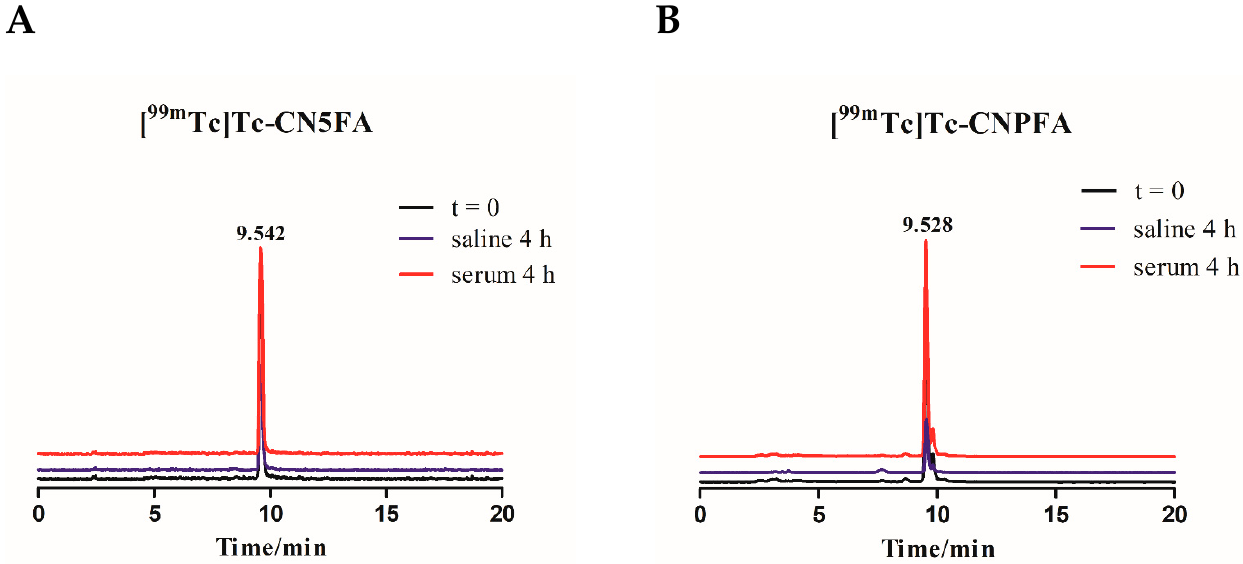
Figure 1. Radiochromatograms of [ 99m Tc]Tc-CN5FA ( A ) and [ 99m Tc]Tc-CNPFA ( B ) in original labeling solution without purification (black line), as well as with incubation in saline at room temperature for 4 h (blue line) and in mouse serum at 37 °C for 4 h (red line).